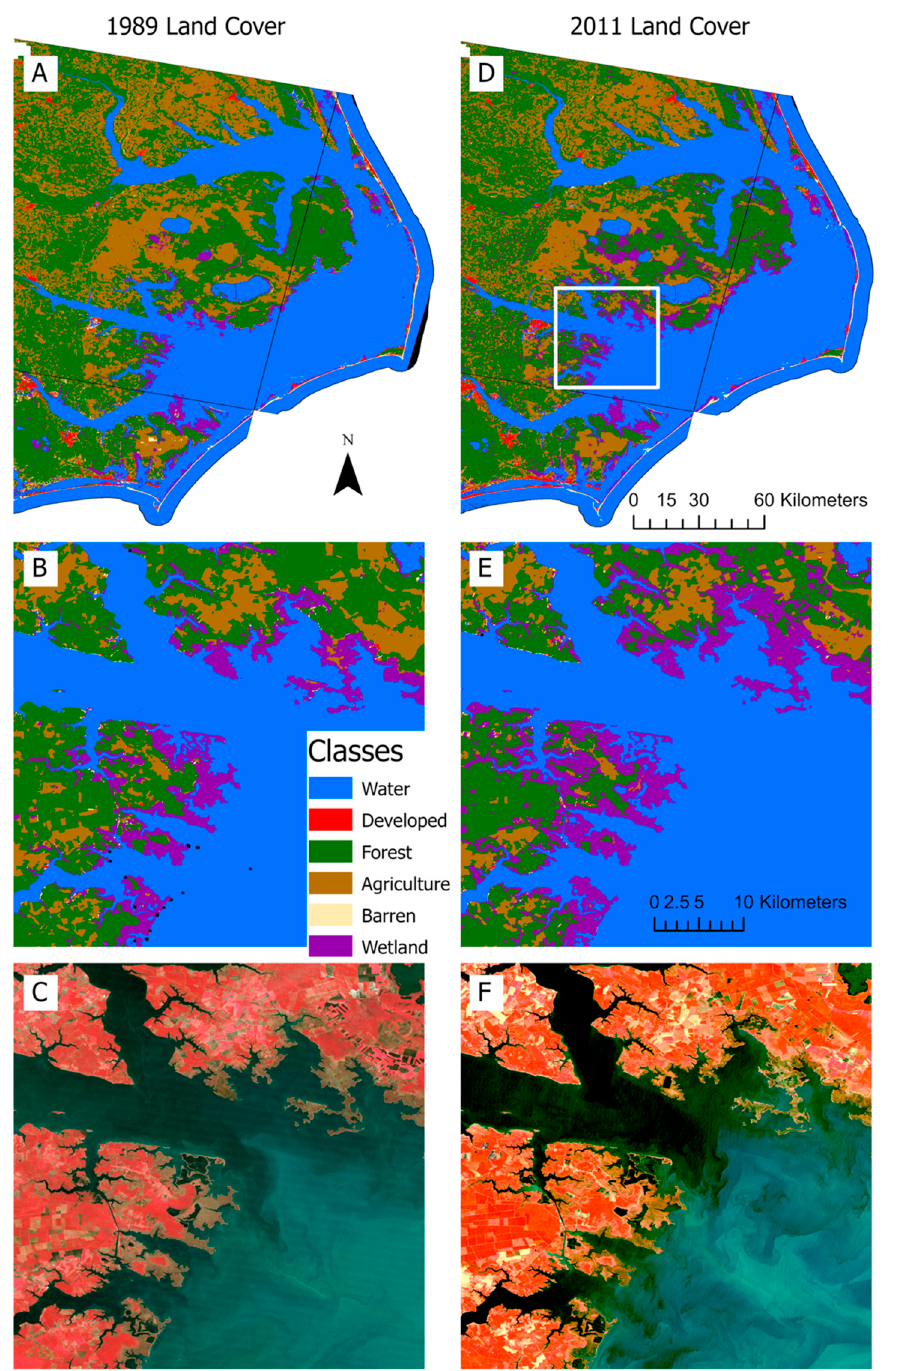
Figure 7. Final output land cover classes from the recurrent convolutional neural network in 1989 (panel A) and 2011 (panel D ). The zoomed region in panels ( B , E ), ( C , F ) is denoted by the white rectangle in panel ( D ). Panel ( E ) shows the creep of wetland inland. Panel ( E ) also shows the large number of pixels that changed to wetland and appear to be along field boundaries as well as ditches and canals that provide connectivity to saltwater. Panels ( C , F ) show Landsat imagery from the spring of the 1989 and 2011, respectively, visualized in false color as NIR-R-G for comparison with model